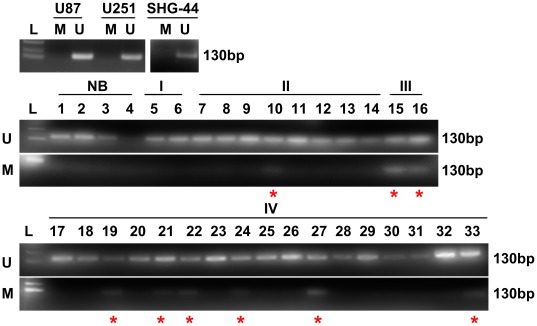
Methylation of neogenin promoter in 3 kinds of glioma cell lines, 4 non-neoplastic brain tissues and 29 gliomas.L: ladder, NB: non-neoplastic brain tissues, U: unmethylated, M: methylated, red asterisks indicate methylation.